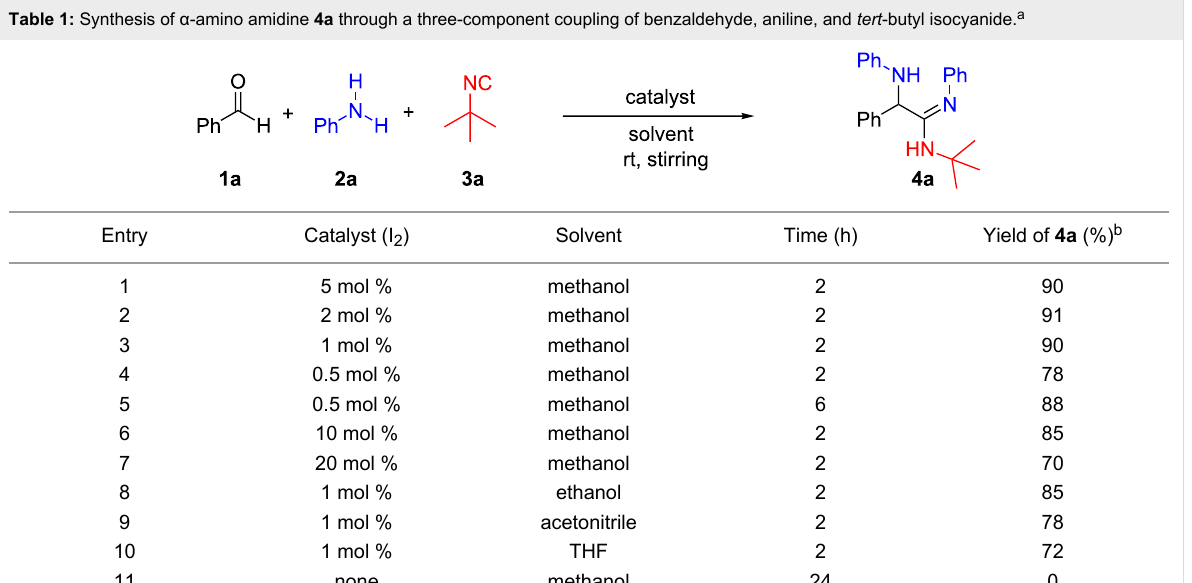
Table 1: Synthesis of α -amino amidine 4a through a three-component coupling of benzaldehyde, aniline, and tert -butyl isocyanide.